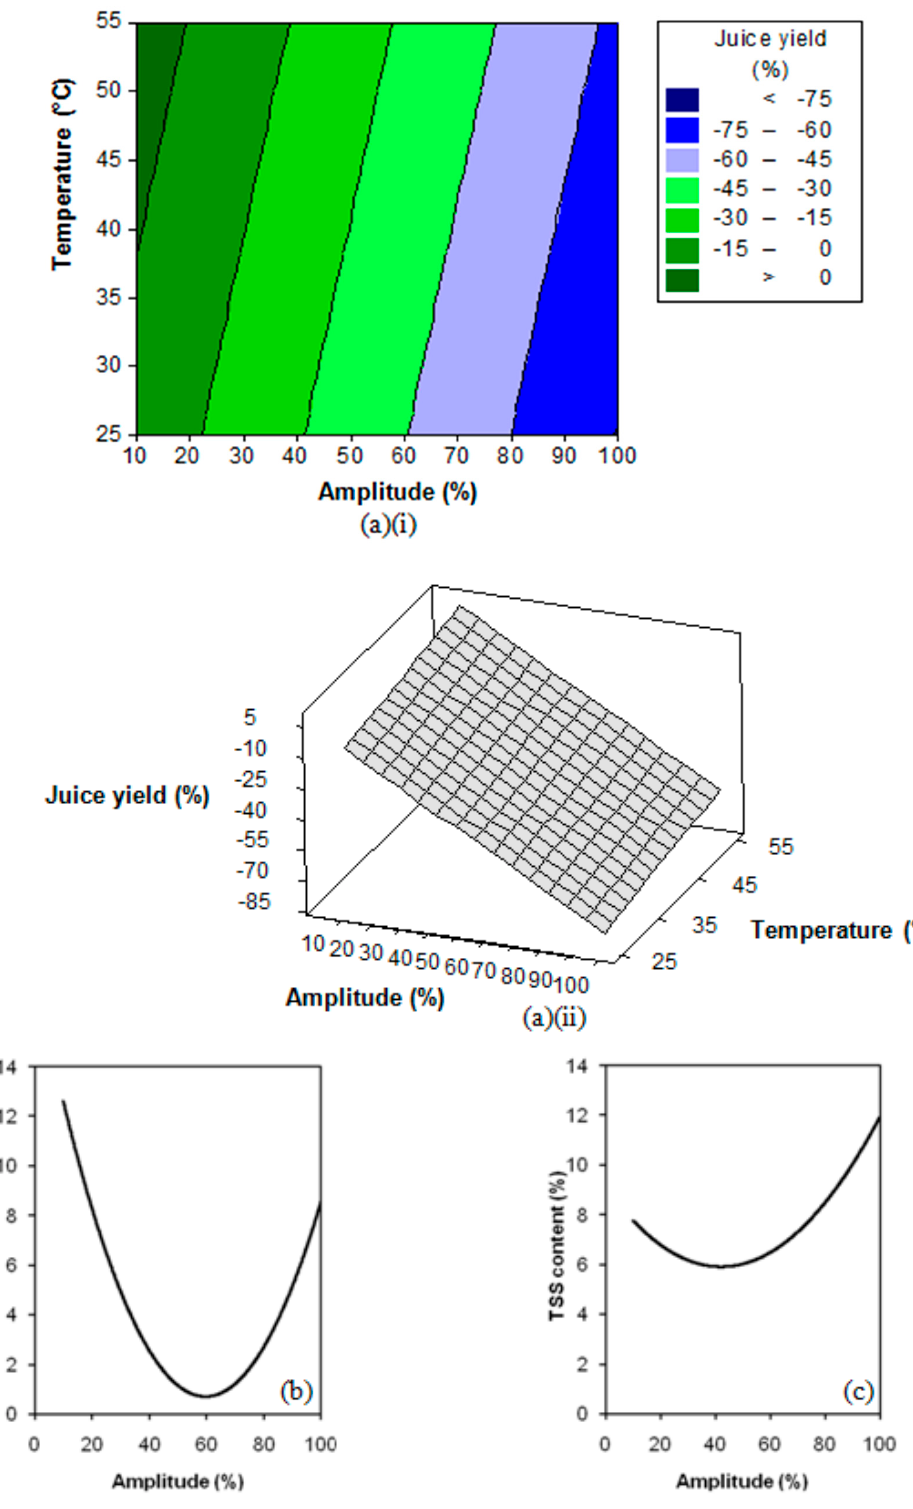
Figure 5. Plots of direct thermosonication-assisted soursop juice extraction responses. ( a ) ( i ) 3D contour plot and ( ii ) 3D surface plot of juice yield, ( b ) Main effect plot of AA content and ( c ) Main effect plot of TSS content.